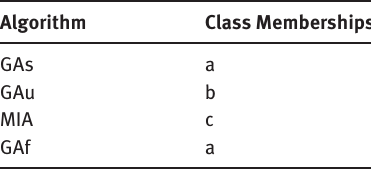
Table 12. Length 49 64 PSK: Tukey HSD Class Memberships.